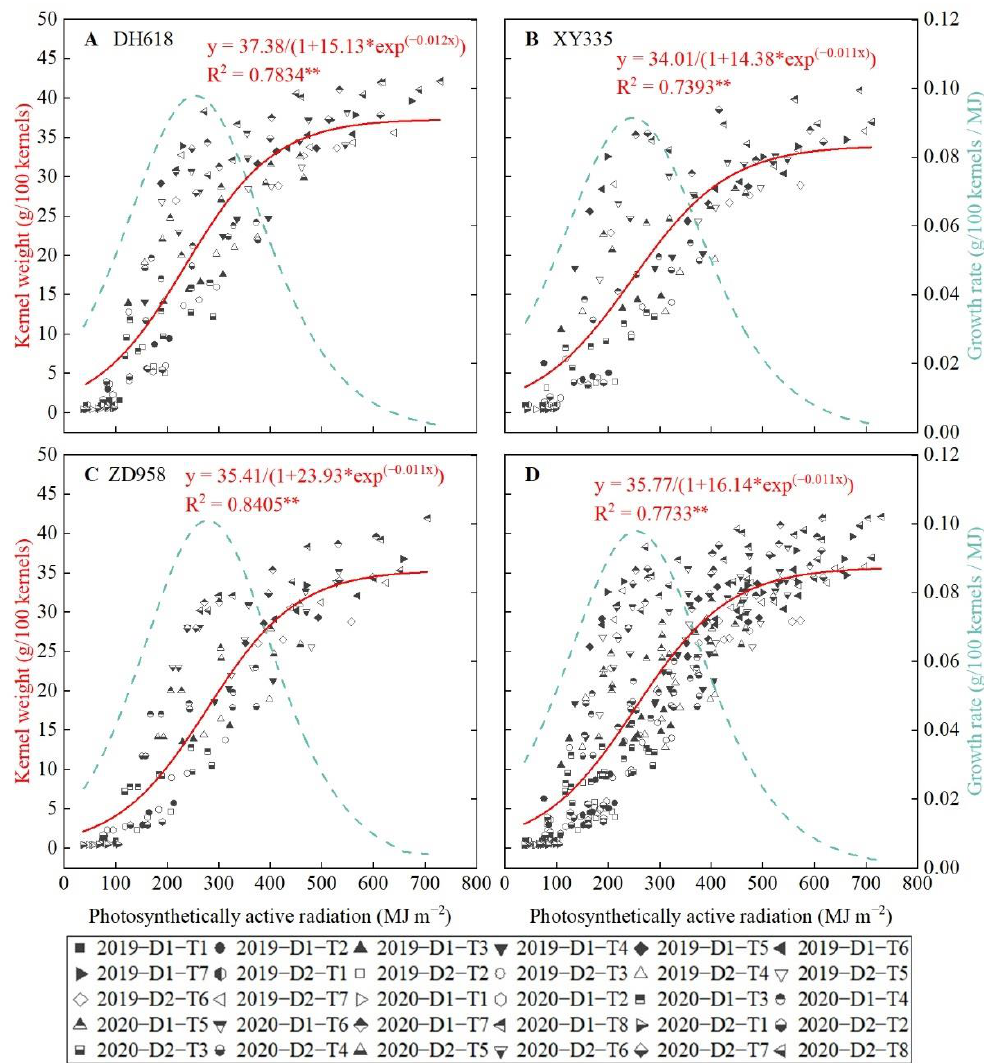
Figure 4. Relationships between kernel weights and growth rate and photosynthetically active radiation from the silking to maturity stages for three cultivars ( A – C ) and all cultivars combined ( D ). Planting density: D1, 7.5 × 10 4 plants ha − 1 and D2, 12 × 10 4 plants ha − 1 . Each T represents a 10 − d interval sampling of kernel weight. ** p ≤ 0.01.